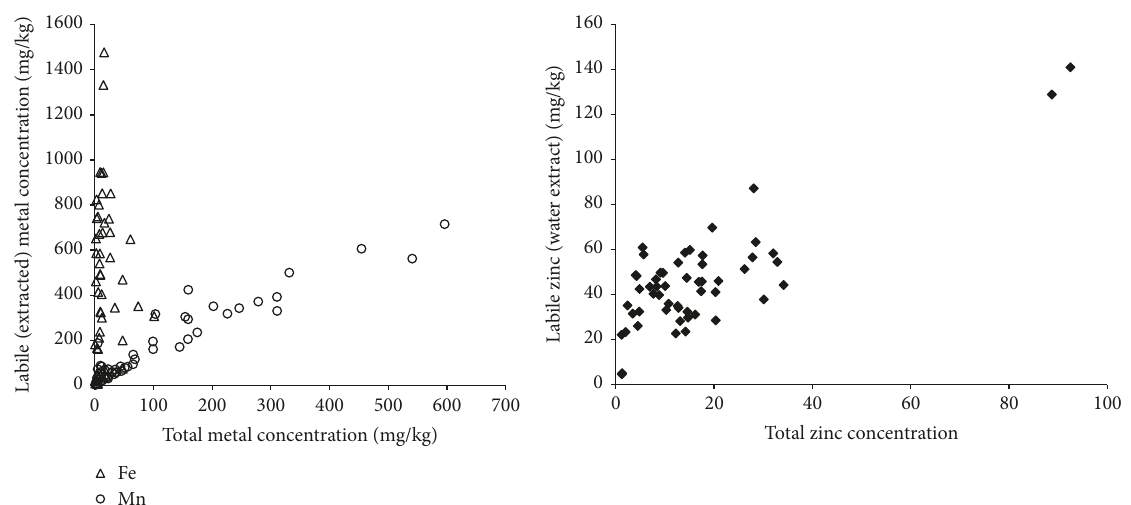
Figure 2: Relationship between Fe, Mn, and Zn contents of the dried herbal samples and the extracted metal contents of the labile fractions in the